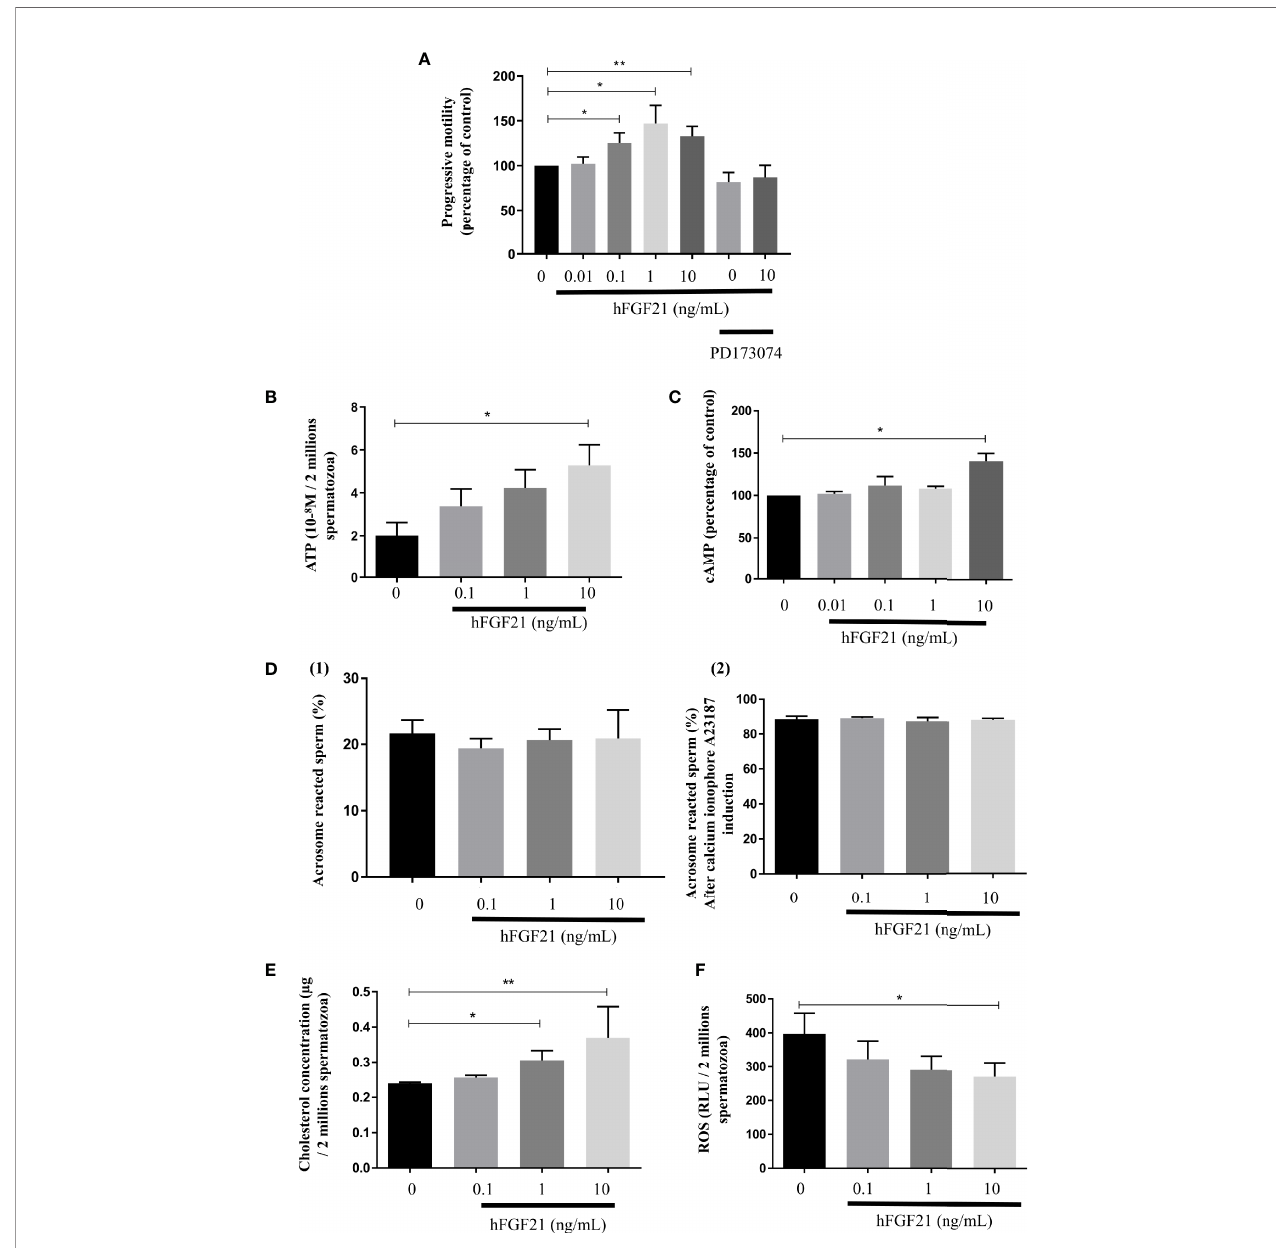
FIGURE 5 | FGF21 treatments increase spermatozoa motility. (A) Sperm progressive motility analyzed by computer-assisted sperm analysis (CASA) after 30 min of stimulation with recombinant FGF21, was presented in percentage of control. A preincubation with the FGFR inhibitor PD173074 was also used in presence of absence of a 30 min of stimulation with recombinant 10 ng/mL FGF21, (n = 8 patients). (B, C) Concentration of ATP in sperm stimulated for 30 min with recombinant FGF21 (10 -8 M per 2.10 6 cells) and cAMP production in percentage of control, (n = 7 patients). (D) Percentage of acrosome-reacted sperm with (2) or without (1) calcium ionophore A23187 was quanti fi ed after PSA staining (percentage of PSA negative cells). Acrosome reaction of spermatozoa after 30 min of stimulation with recombinant FGF21 (n = 5 patients). (E) Total cholesterol concentration quanti fi ed in human spermatozoa after 30 min of stimulation with recombinant FGF21 (µg per 2.10 6 cells, n = 7 patients). (F) ROS levels in human spermatozoa incubated with increasing concentrations of recombinant FGF21 for 30 min (relative luminescence units per 2.10 6 cells, n = 7 patients). *p < 0.05, **p <